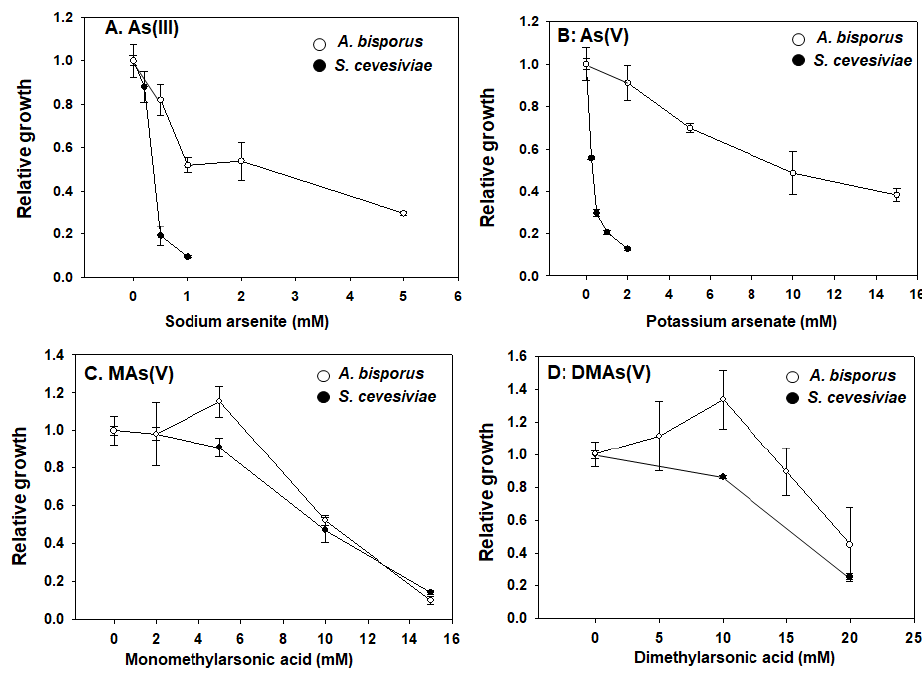
Figure 1. Arsenic toxicity in A. bisporus mycelium and in S. cerevisiae . Mycelium was purified from the commercial growing kit in malt extract agar containing chloramphenicol (50 mg/L). The purified mycelium was then aseptically grown in a liquid malt extract medium (3 mL) supplied with chloramphenicol (at final concentration of 50 mg/L) and various arsenic compounds at indicated concentrations ( A – D ). After growing for two weeks at room temperature, the mycelium was sonicated and OD 600 was monitored to reflect their growth. Yeast was also tested under similar arsenic treatment conditions and used for comparison.